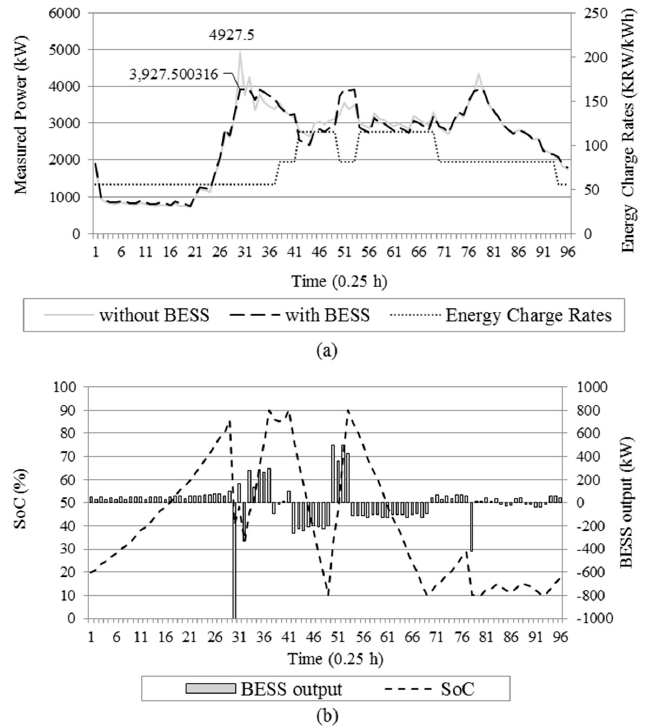
Figure 5. Result of Case 3 ( a ) measured power, and ( b ) BESS output and SoC.